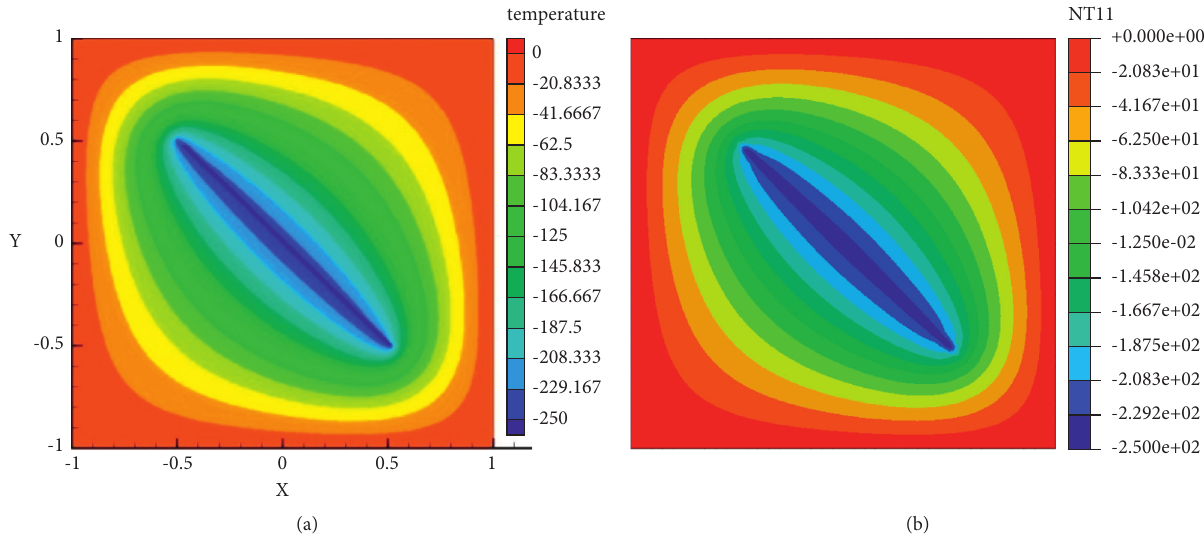
Figure 15: Temperature contour in case of isothermal inclined crack at t � 100s: (a) PD solution; (b) FEM solution.